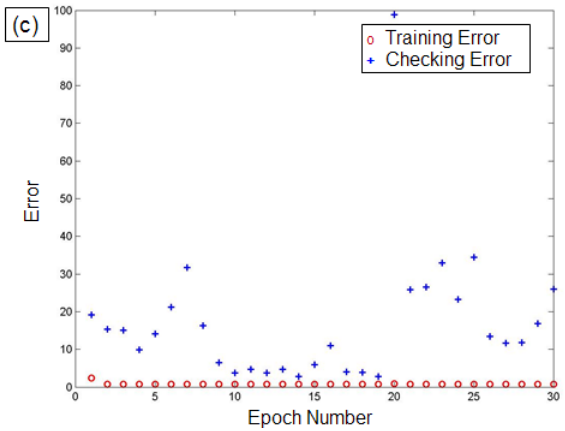
Figure 7. ANFIS training and checking errors for: ( a ) Ra , ( b ) kw , and ( c ) mh. Table 5. ANFIS optimal parameters obtained through GA.